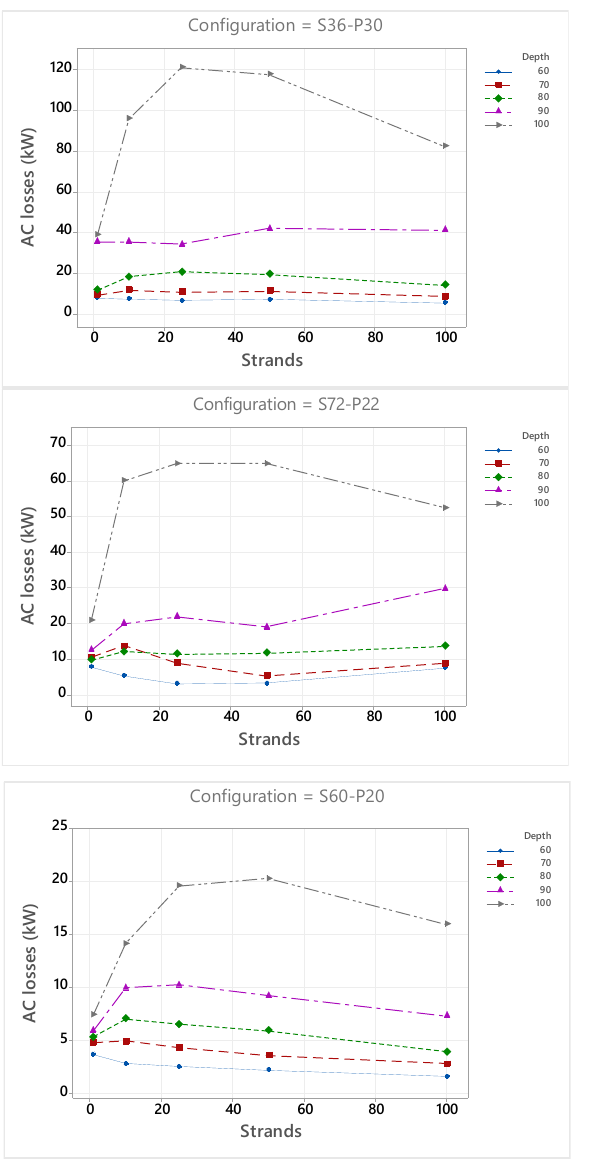
Figure 7. Stranding effect on the AC/DC loss ratio.